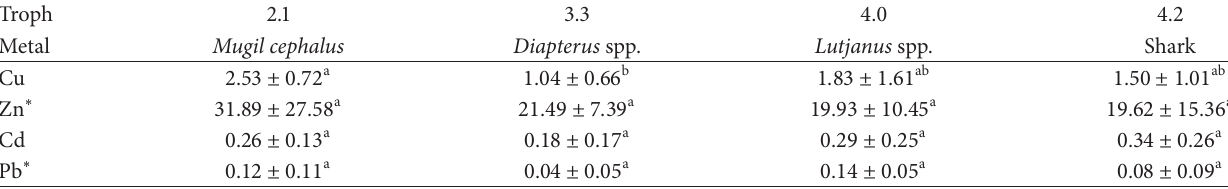
Table 2: Trophic level (Troph) and mean metal concentrations ( 𝜇 gg − 1 , dry weight) in edible muscle of fishes from markets of NW Mexico. Troph